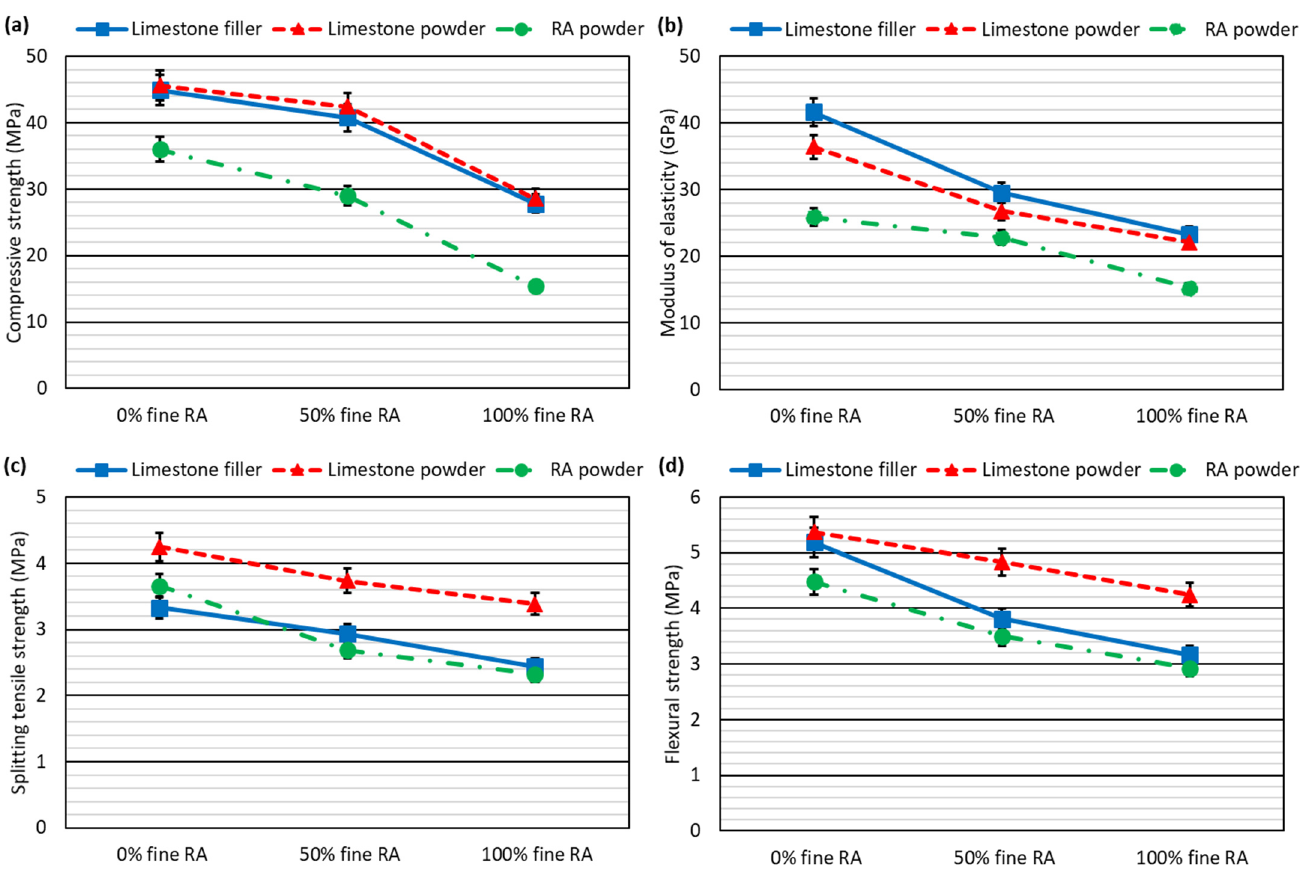
Figure 3. Mechanical performance of SCC mixes: ( a ) compressive strength; ( b ) modulus of elasticity; ( c ) splitting tensile strength; ( d ) flexural strength.